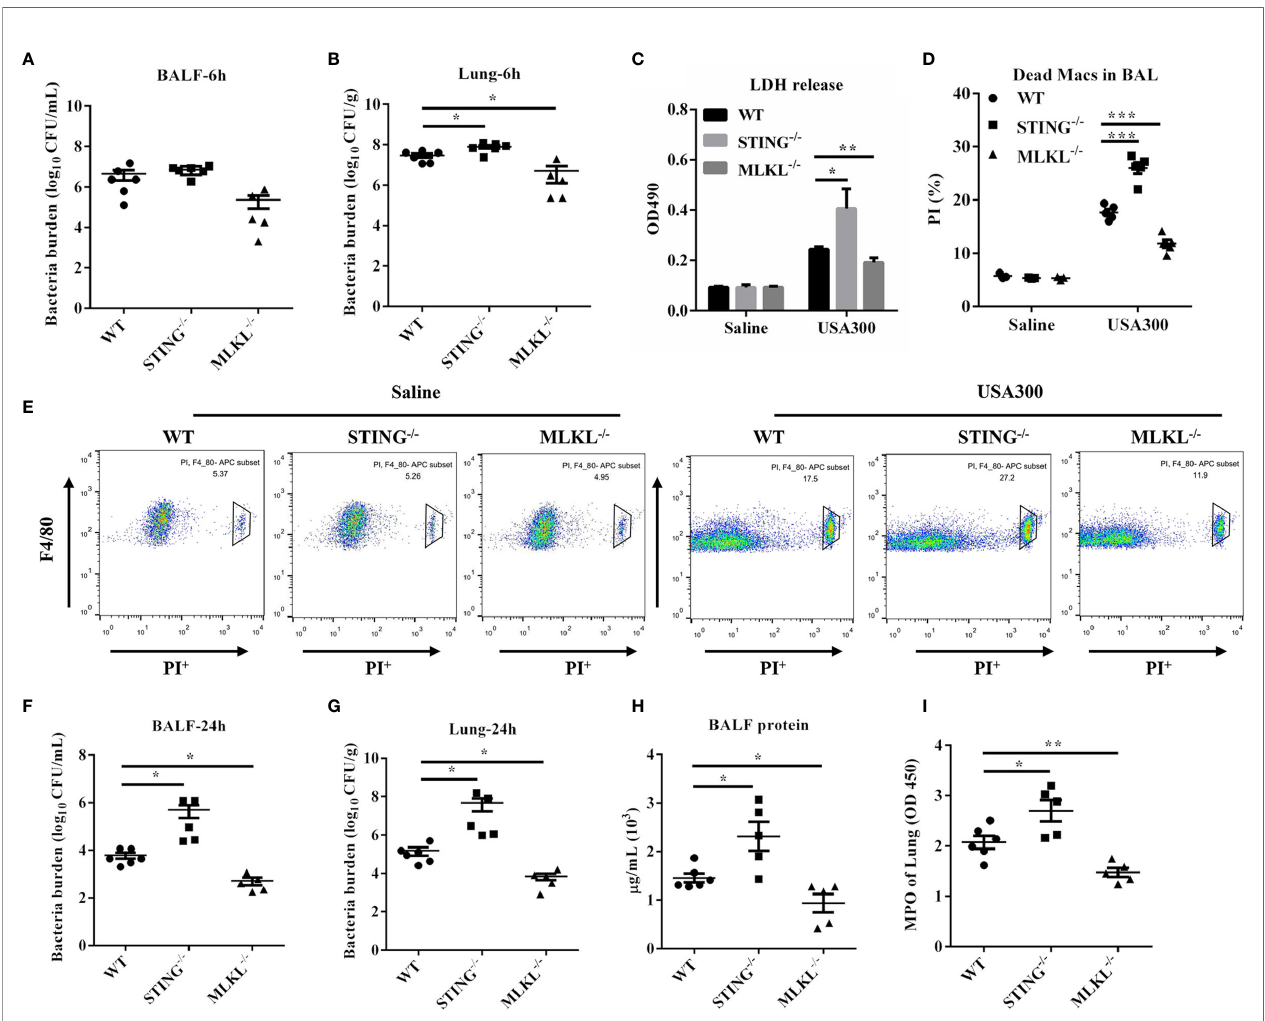
FIGURE 6 | MLKL -/- mice are resistant to pulmonary S.aureus infection. WT, STING -/- , and MLKL -/- mice (N = 5-6/group) were infected intranasally with a sublethal inoculum of S.aureus (1 × 10 8 CFU/mouse) and then were euthanized at 6 hpi or 24 hpi to quantitate the bacterial burden in (A, F) BALF, (B, G) lung. (C) LDH released in BALF at 6 hpi. (D, E) Propidium iodide positive (PI + ) macrophages in the BALF were analyzed by fl ow cytometry at 6 hpi. (H) Total protein in BALF was measured at 24 hpi. (I) The homogenate supernatant of the lung was also used to determine the activity of MPO at 24 hpi. All data are shown as mean ± SEM. One- way ANOVA with Bonferroni ’ s multiple comparison test was performed. Statistical signi fi cance is indicated by *p < 0.05, **p < 0.01, and ***p <